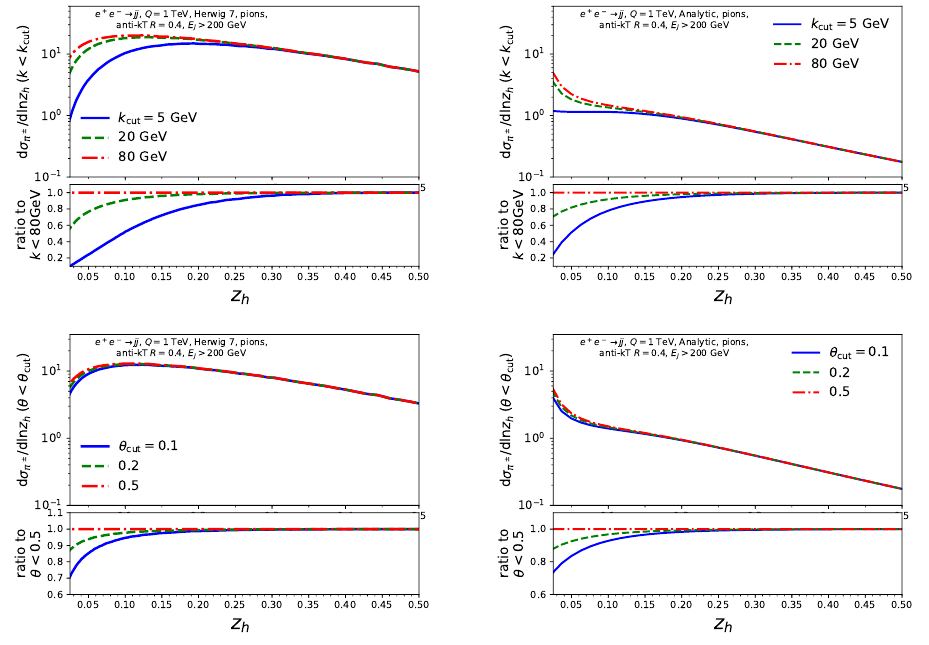
Figure 14 . The fragmentation spectrum of charged pions with a cut on their transverse momentum (top) or angle (bottom), from Monte Carlo (left) and through the analytic calculation (right). The ratio to the \most-inclusive" cuts, (cid:18) cut = 0 : 5 or k cut = 80 GeV, are shown for each